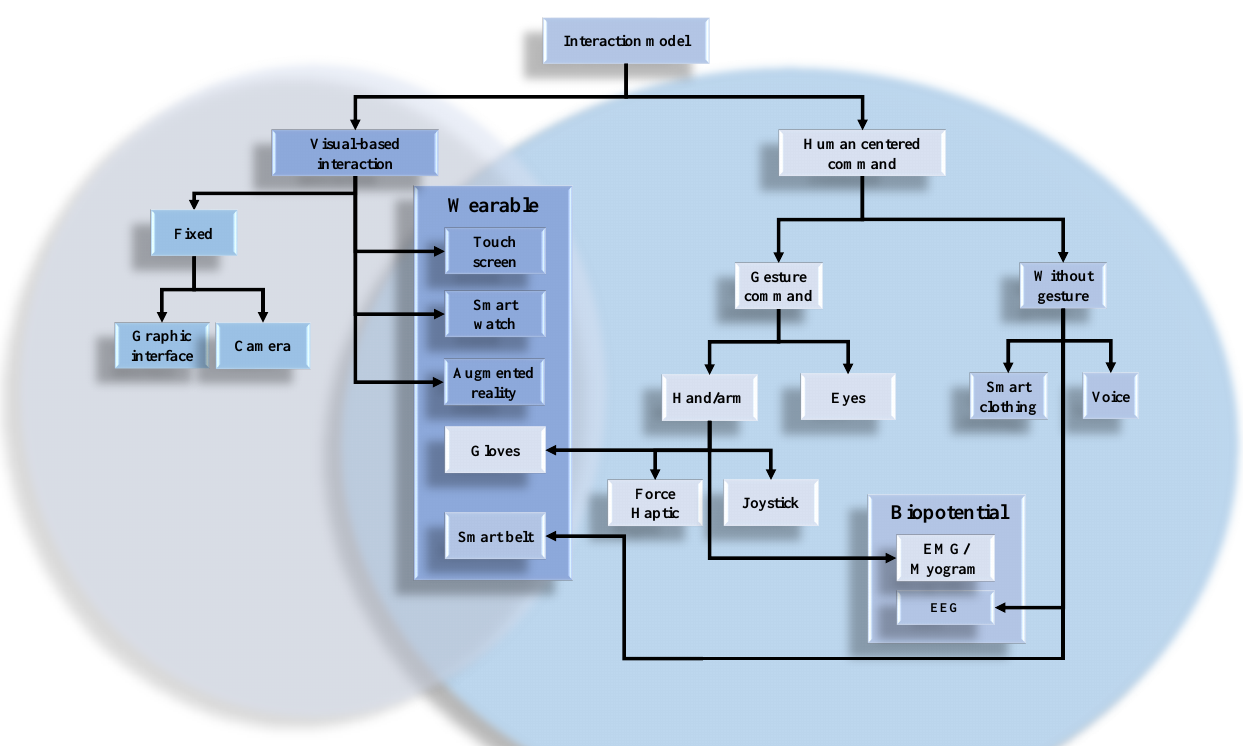
Figure 1. Taxonomy of interaction support for mobile robots